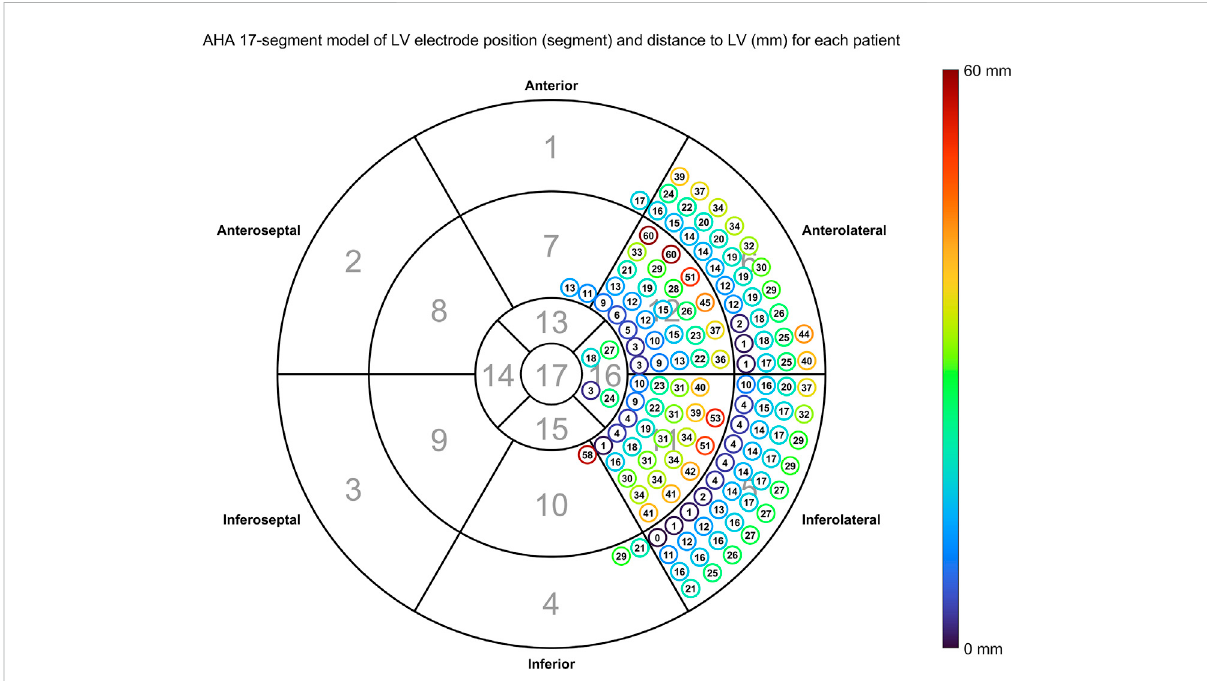
FIGURE 7 Distance between anatomical LV pacing site and nearest node activating at the measured Δ QLV . Each encircled number shows the computed distance between estimated position and position determined by physician. The color of a circle is a visual representation of these